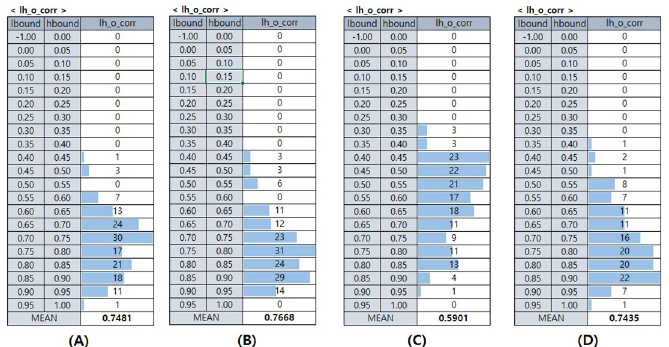
Fig 6. Describes the distribution of lh _ o _ corr (the result of step computing difference) for all the test images. the number in the column lh _ o _ corr means the number of cases with lh _ o _ corr value between lbound and hbound . (A) , (B) , (C) , (D) means the lh _ o _ corr values of the dataset “Vehicle vs. Non-vehicle”, “traffic signs”, “traffic signs with few classes” and “traffic signs (only speed limit signs)”, respectively. There is no case that lh _ o _ corr is less than 0 for any dataset, and the average of lh _ o _ corr is about